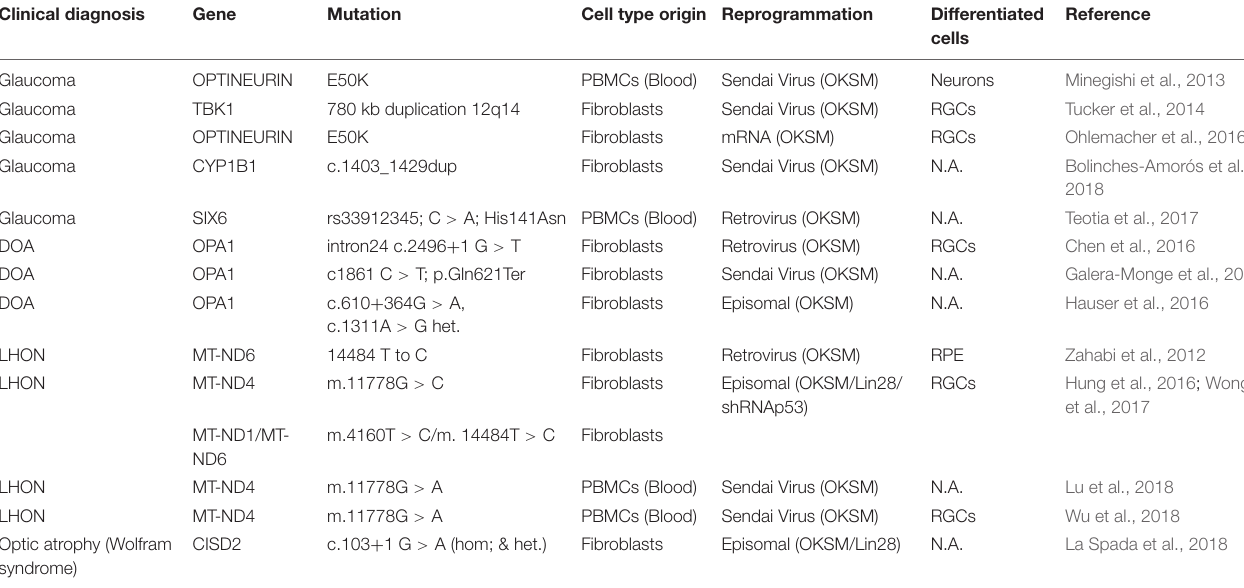
TABLE 3 | Published PSC lines carrying mutation for optic neuropathies and disease modeling studies/PSC-derived pathological models for optic neuropathies. Clinical